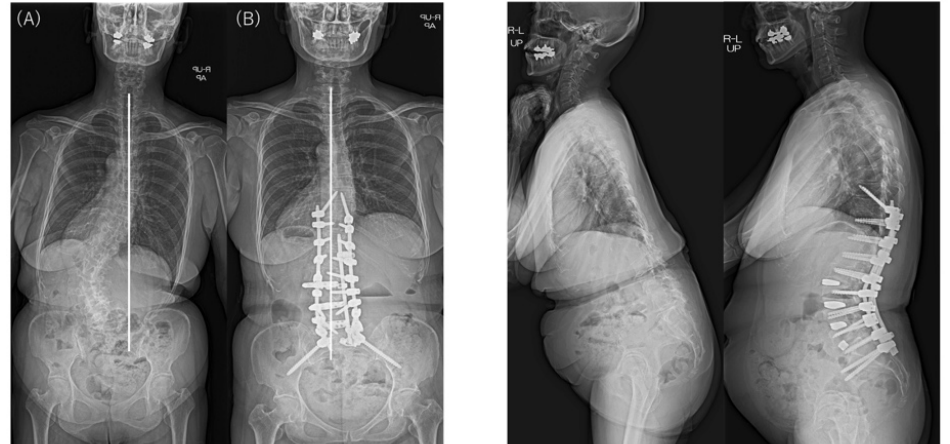
Figure 2. Preoperative and postoperative standing radiographs showing coronal and sagittal cor- rection using anteroposterior staged surgery for ASD in a 63-year-old woman with type 1 CM. CBD changed from 41.6 mm preoperatively ( A ) to –3.2 mm postoperatively ( B ), with the C7 plumb line on the opposite side of the CBD. Sagittal alignment improved significantly, and postoperative CM also improved to CBD <20 mm. CM, coronal malalignment; CBD, coronal balance distance.